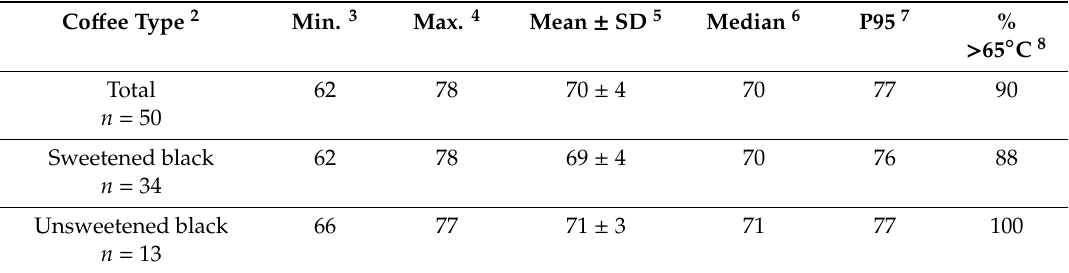
Table 1. Summarized results of bestsellers’ serving temperatures ( ◦ C) in 50 low-cost food service establishments (LCFS), according to co ff ee type 1